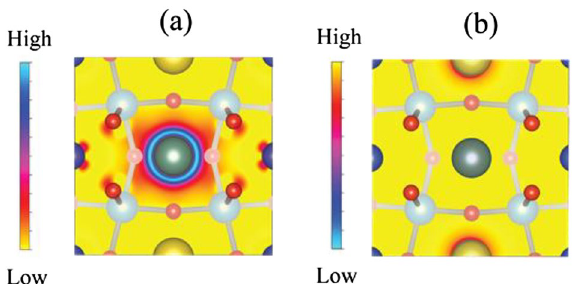
Figure 13. ( a ) and ( b ) the positive and negative electron-density differences of the (100) plane between NYCTO and CCTO,